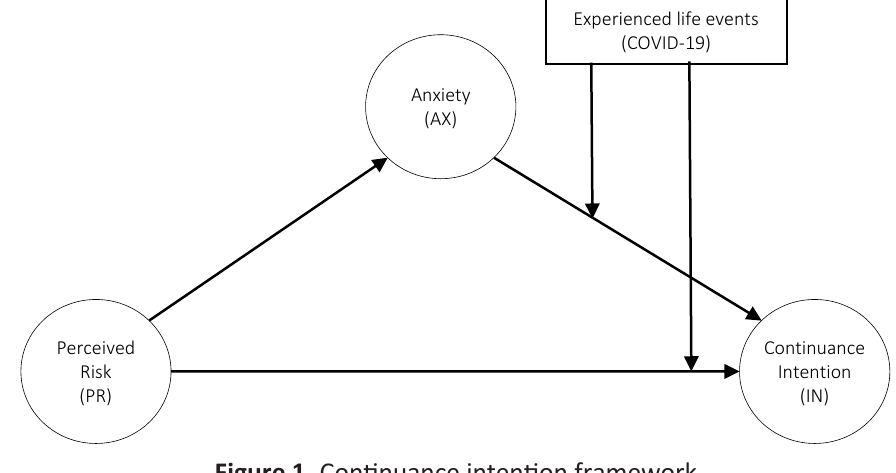
Figure 1. Continuance intention